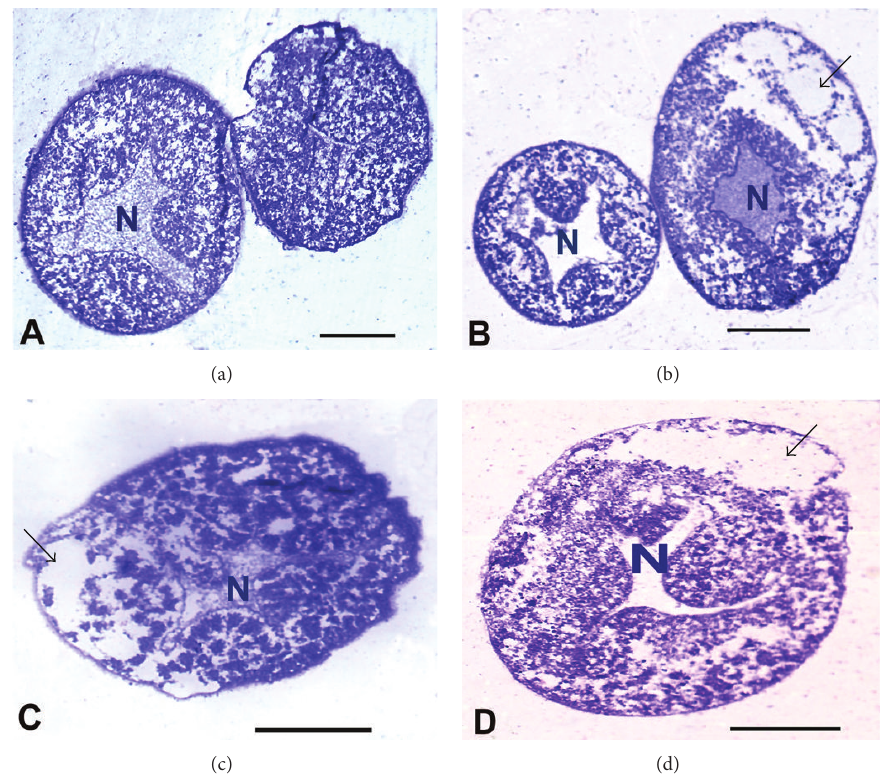
Figure 2: Bright-field images of different 1 𝜇 m (semithin) sections from different areas of teratocytes of M. aethiopoides were stained with 0.5% toluidine blue and counterstained with 0.5% acid fuchsin showing amorphous nuclei. N: nuclei. Large unstained areas (arrow). Scale bar = 50 𝜇